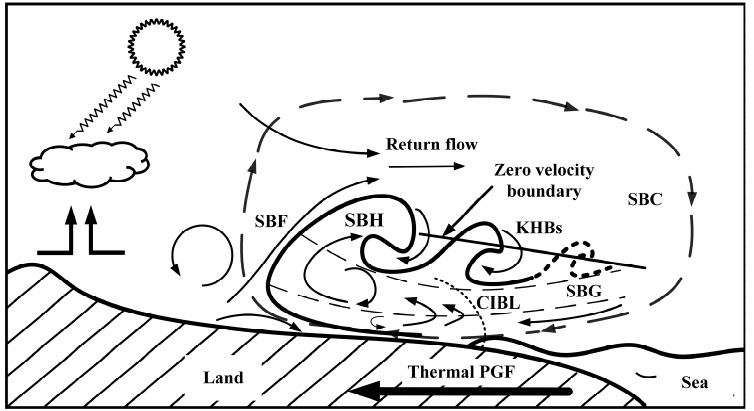
Figure 1. The structure of sea breeze and airflow trajectory.